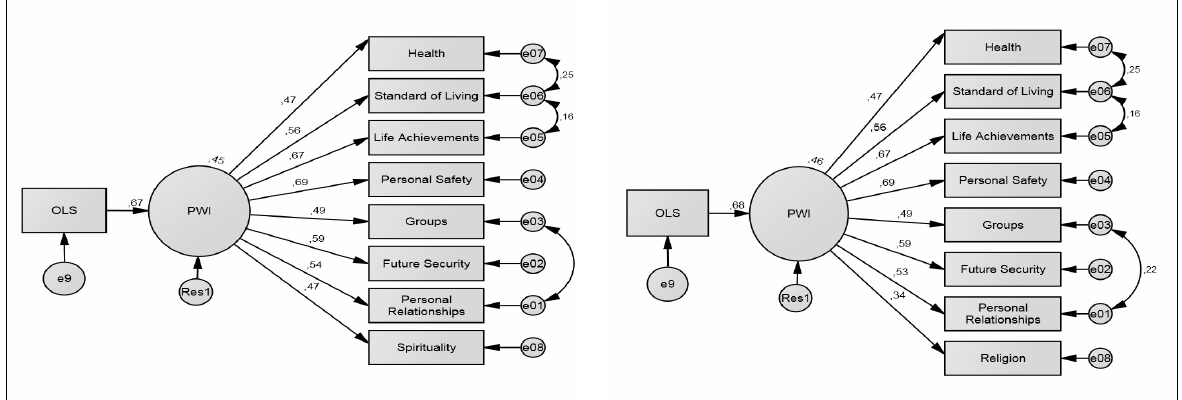
Figure 2. Structural equations model of the OLS with PWI and the spirituality and religion items with joined data from Chile and Brazil, with standardized